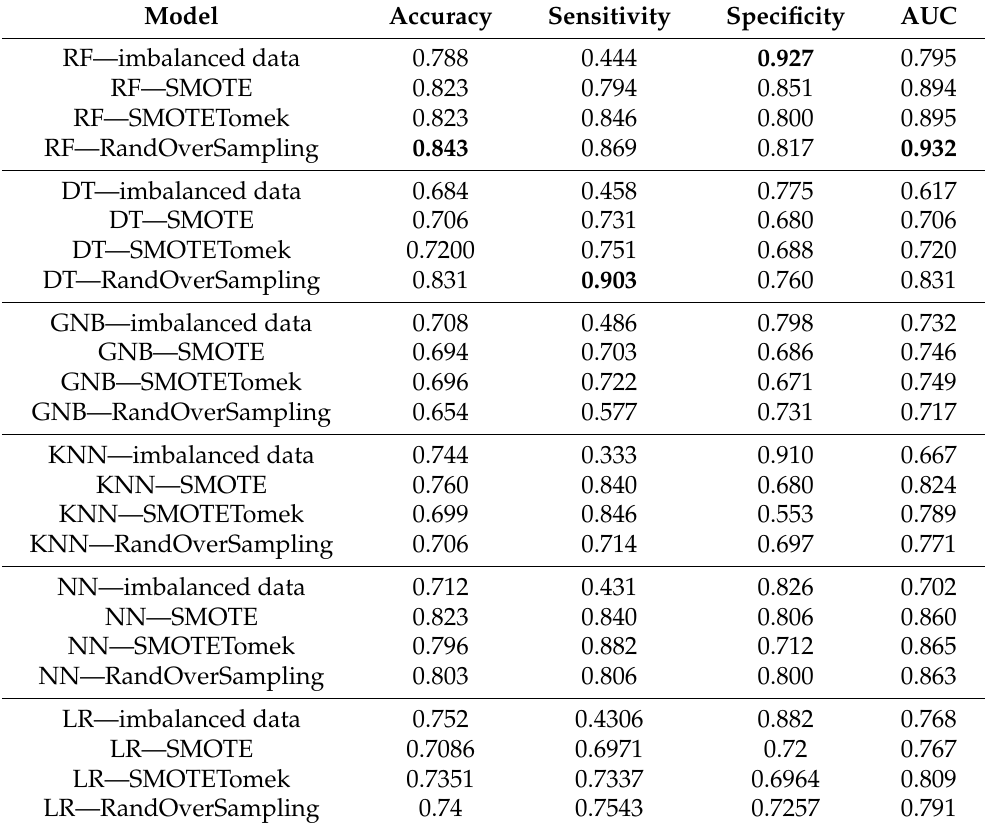
Table 6. Random forest recursive feature elimination with different classification algorithms. Values in bold are the maximum of each